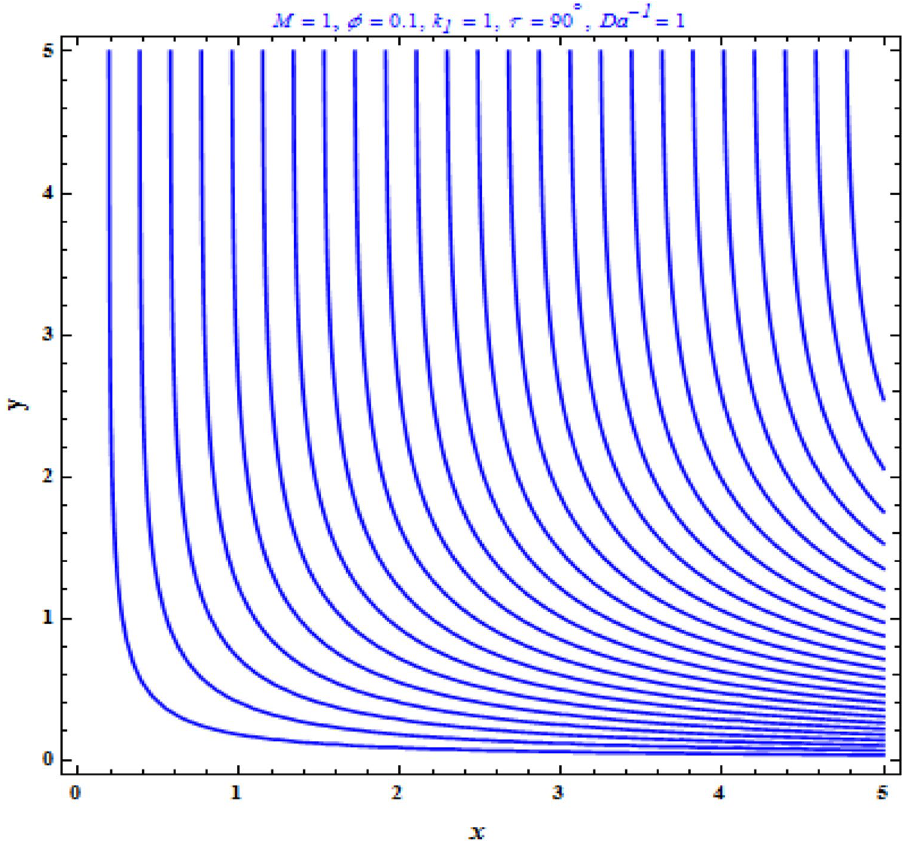
Figure 12. Streamlines for stretching